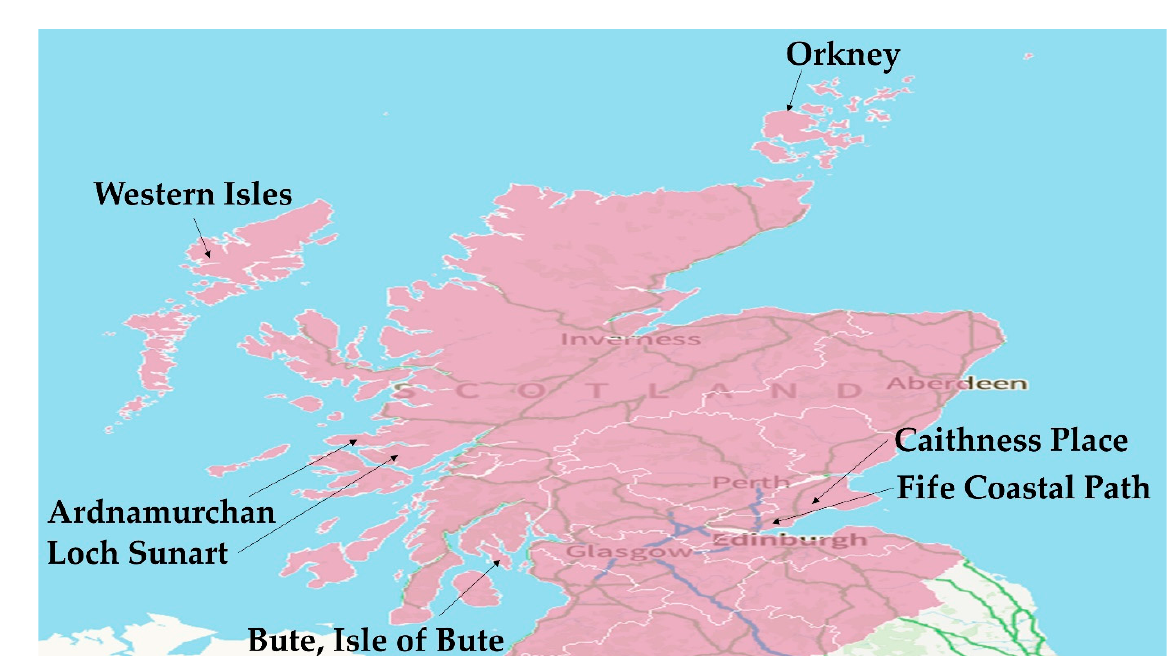
Figure 5. The industrial seaweed harvesting areas in Scotland; the map has been produced by Omar Al-Dulaimi using a map of Scotland downloaded from https://www.visitscotland.com/destinations-maps/ accessed on 20th April 2021.